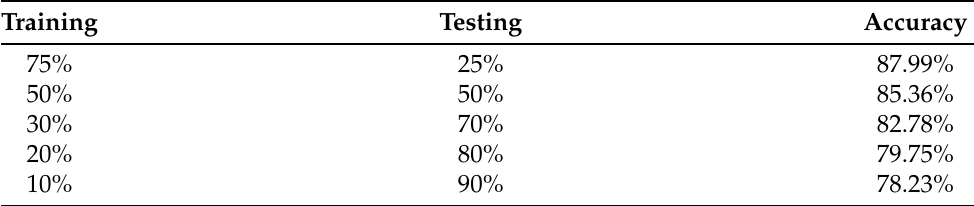
Table 3. Accuracy using 55,788 tweets with different training-testing splits.